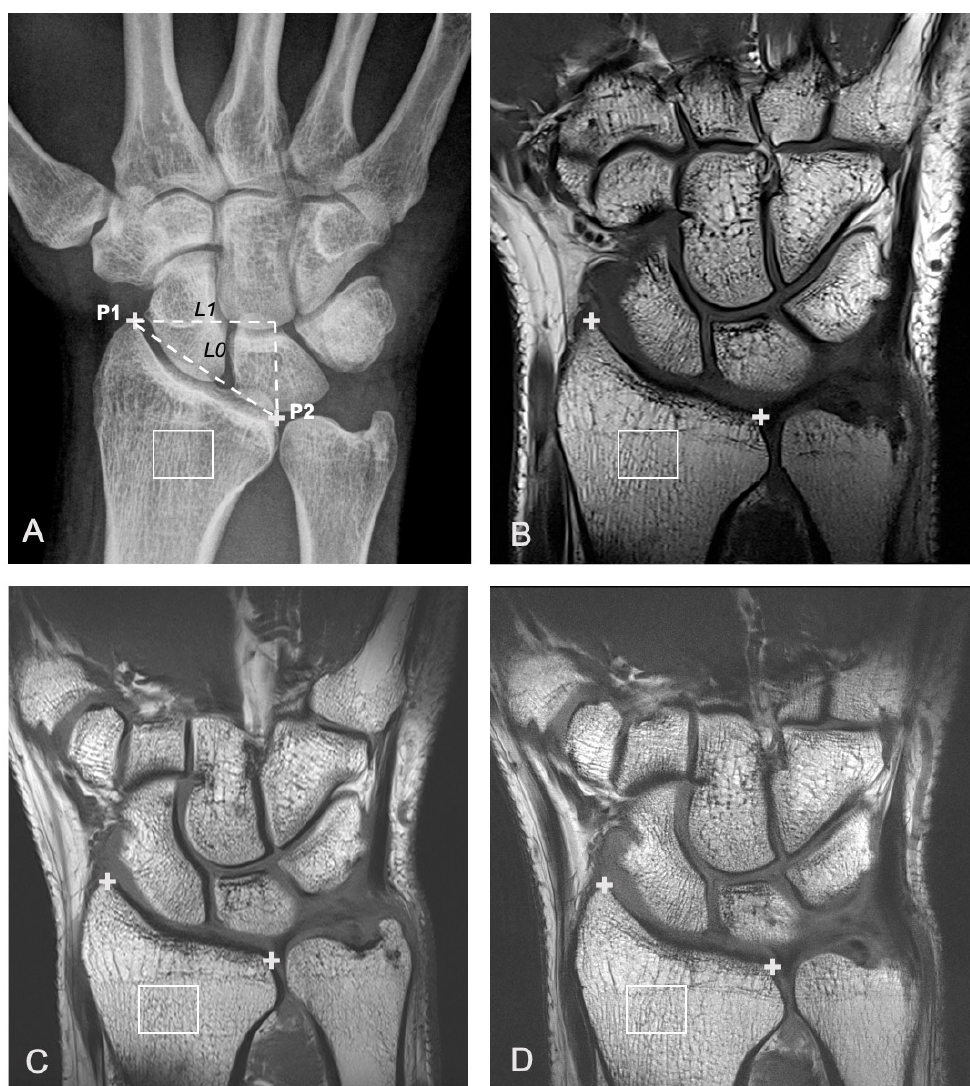
Figure 1. A 31-year-old female with ulnar-sided right wrist pain that had lasted several months. Right wrist imaged with different imaging modalities in a participant within the patient group, including frontal a.p. radiographic view ( A ), 3T coronal T1w turbo spin echo (TSE) MR image ( B ), and two different 7T coronal T1w TSE MR images acquired with different TE and TR parameters ( C : 7T T1w TSE-fast and D : 7T T1 TSE-high resolution (HR)). The center of the region of interest (ROI) (white box) is located 0.4 × L1 on the ulnar side of P1 (+) (in the horizontal direction) and 0.25 × L0 below P2 (+) ( A – D ). The width and height of the ROI were 0.4 × L0 and 0.3 × L0, respec- tively. L0 is defined as the distance between P1 and P2 (oblique dashed line). L1 is defined as the horizontal distance between P1 and P2 (horizontal dashed line) ( A ).